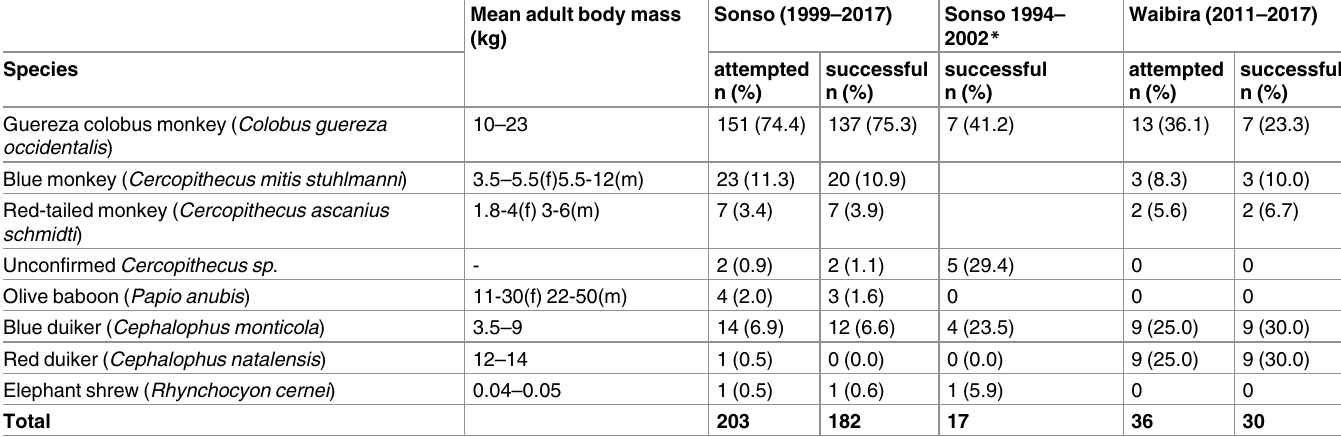
Table 1. Specialization of hunting in the Budongo chimpanzees,